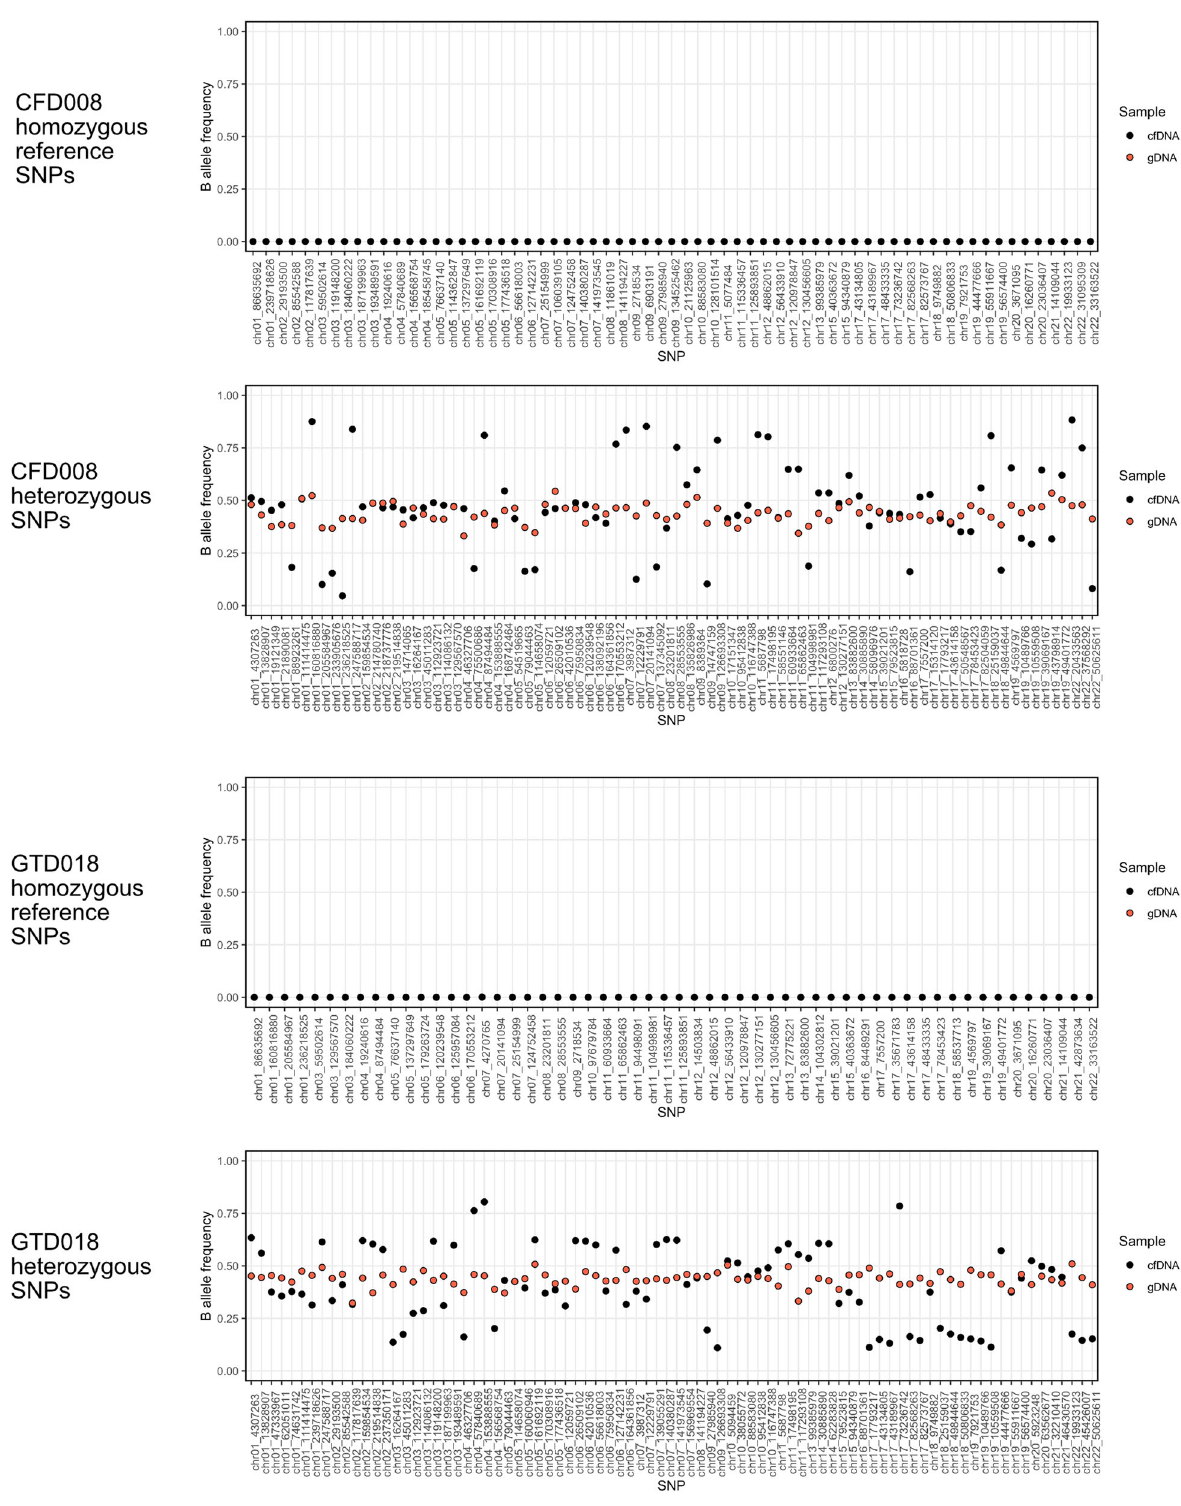
Fig. 3 Copy number alterations in non-gestational tumour cfDNA. Upper panels for each patient show the absence of non-host alleles at SNPs for which the patient is homozygous. Lower panels for each patient show the B allele frequency for heterozygous SNPs, in order of chromosome and position, revealing deviations from the patients ’ gDNA